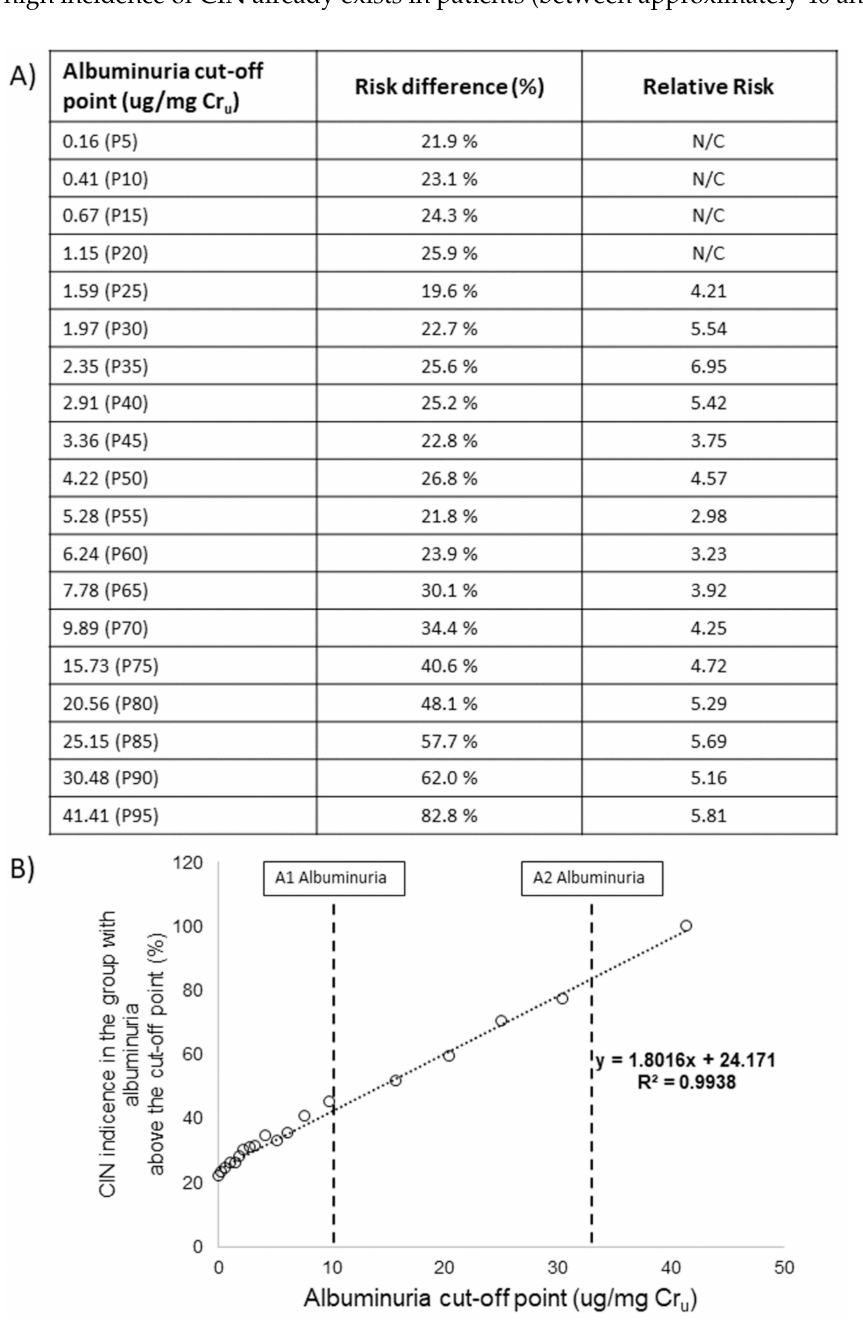
Figure 4. Risk difference and relative risk of suffering CIN for individuals with high albumin excretion compared to those with low excretion, taking into account different cutoff points ( A ) and incidence of CIN in patients with high albumin excretion depending on the cutoff points ( B ). A1 and A2 albuminuria: categories of albuminuria according to KDIGO, 2012 [19]. CIN: contrast-induced nephropathy; Cr u : urinary creatinine; N/C: not calculable; P: percentile; R: correlation